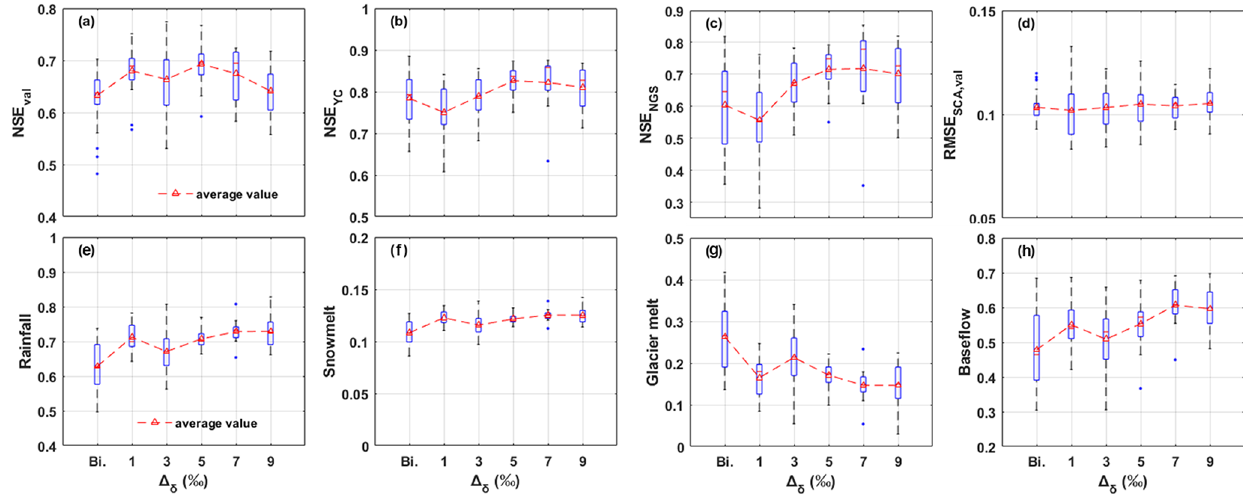
Figure 5. Model performances (a–d) and runoff component contributions (e–h) in the YTR basin in different scenarios using different glacier isotope input (Experiment 1). Subplot (a) and (d) are the performances for Nuxia streamflow and SCA simulation in the validation period, respectively. Subplot (b) and (c) are the performances for streamflow simulation at internal stations Yangcun and Nugesha, respectively. Subplots (e) – (g) are the contribution of runoff components based on water source definition. Subplot (h) is the contribution of baseflow based on the runoff pathway definition.